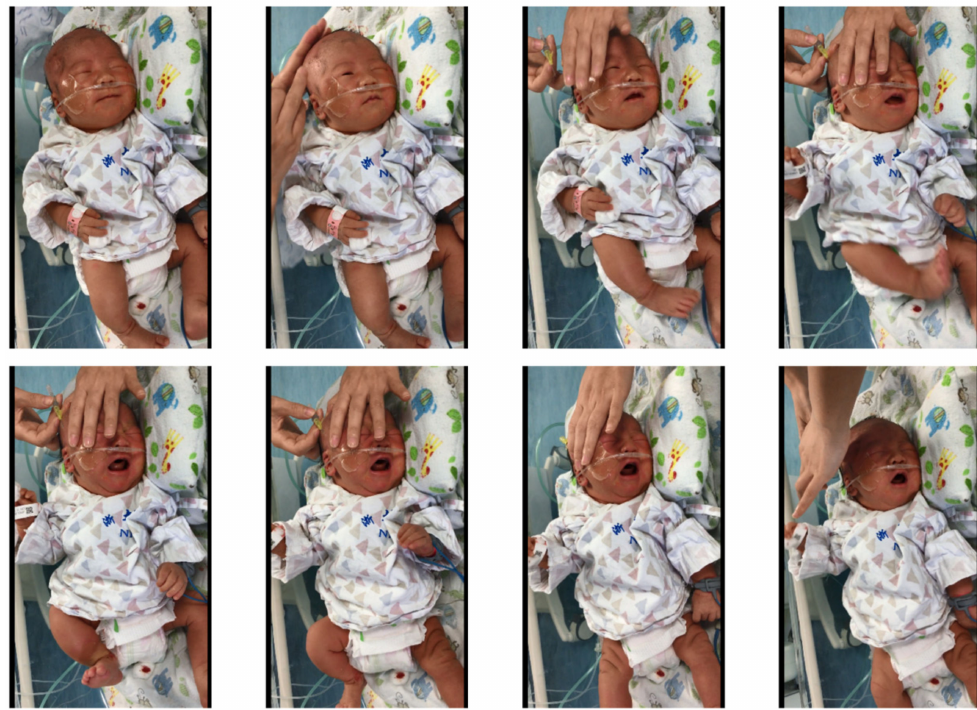
Figure 2. Samples of image sequence in a neonatal pain